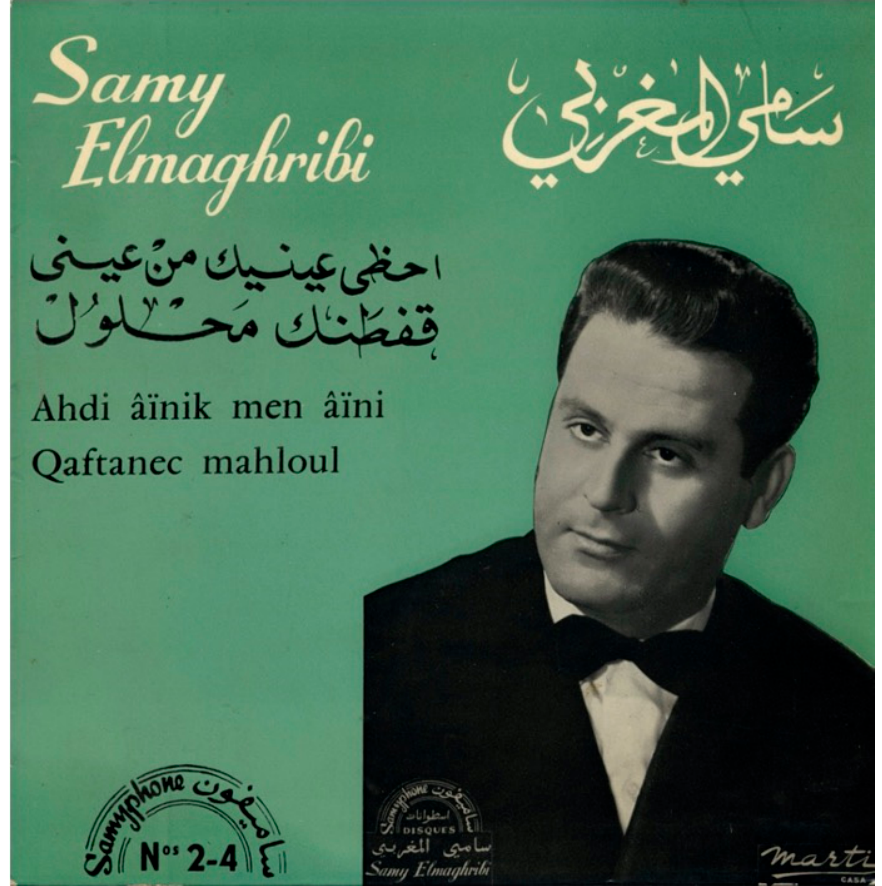
Figure 2. Cover of Samyphone number 2, composed in 1952 and recorded in 1955. (Courtesy of Yolande Amzallag, Foundation Samy Elmaghribi).